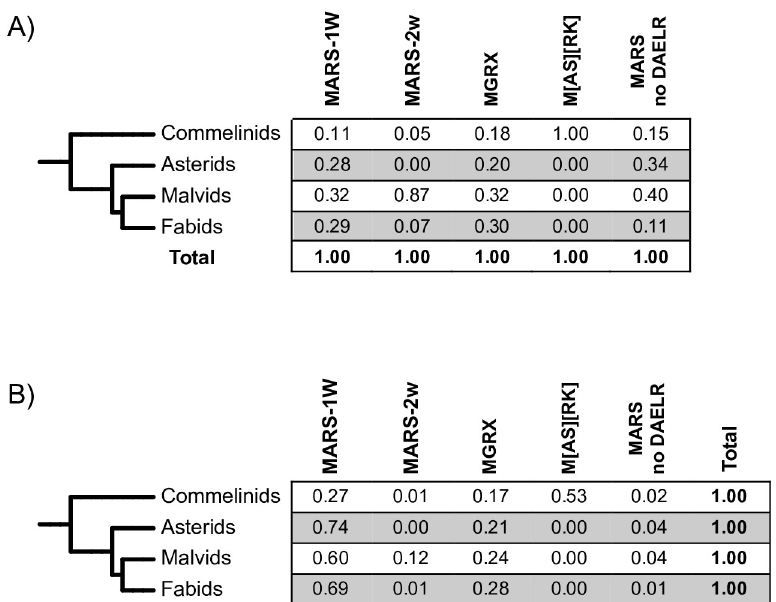
Fig 3. Distribution of LEA3 architectures in plant clades. The different plant species groups were combined into clades, and numbers were normalized as described in the Materials and Methods. The numbers represent A) the fraction of a plant clade that have one of the architectures, and B) the fraction of a protein architecture within one plant clade.